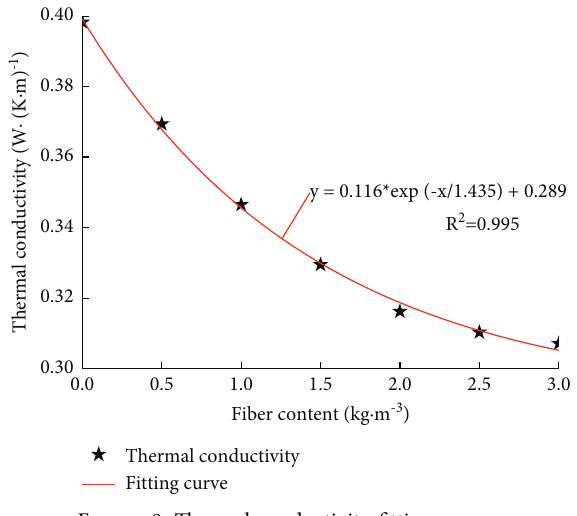
Figure 9: Thermal conductivity fitting